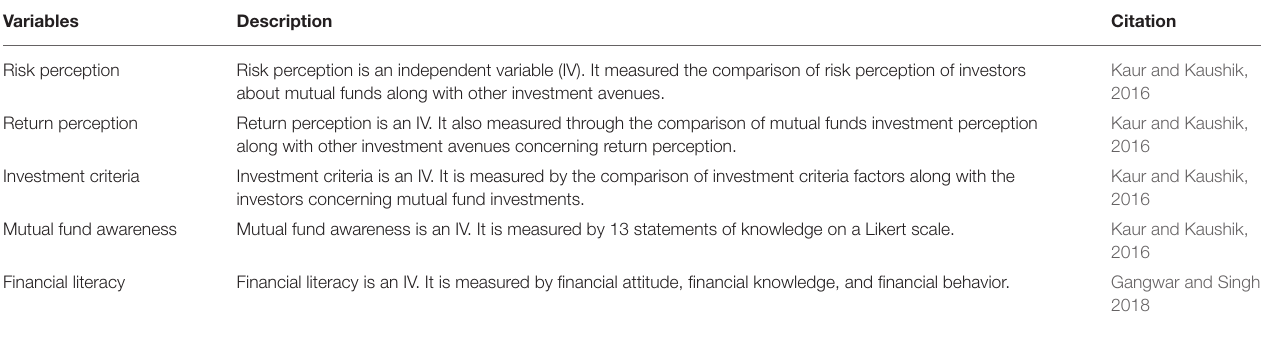
TABLE 1 | Measurement of variables.